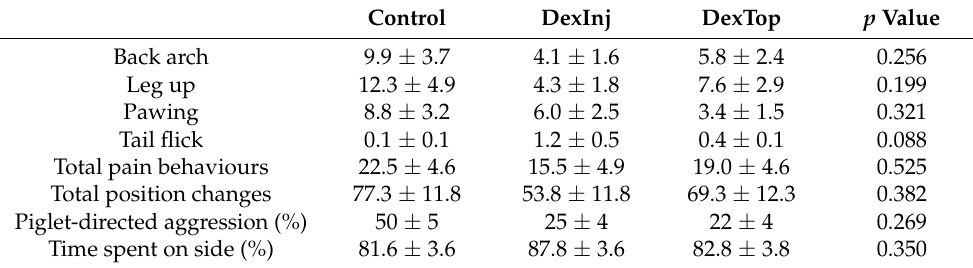
Table 3. Effects of dexamethasone administered the day of farrowing (0700 h, gestation day 115) as a vulval injection (DexInj), applied topically into the vagina (DexTop), or no steroid treatment (Control) on mean ( ± SE) sow behaviours during 24 h from onset of farrowing. The number of sows that displayed any piglet-directed aggression is expressed as a percentage over the total treatment group (95% CI). In addition, the time each sow spent in the laying position (udder exposed) is presented as a percentage over the total 24 h observation period. Control